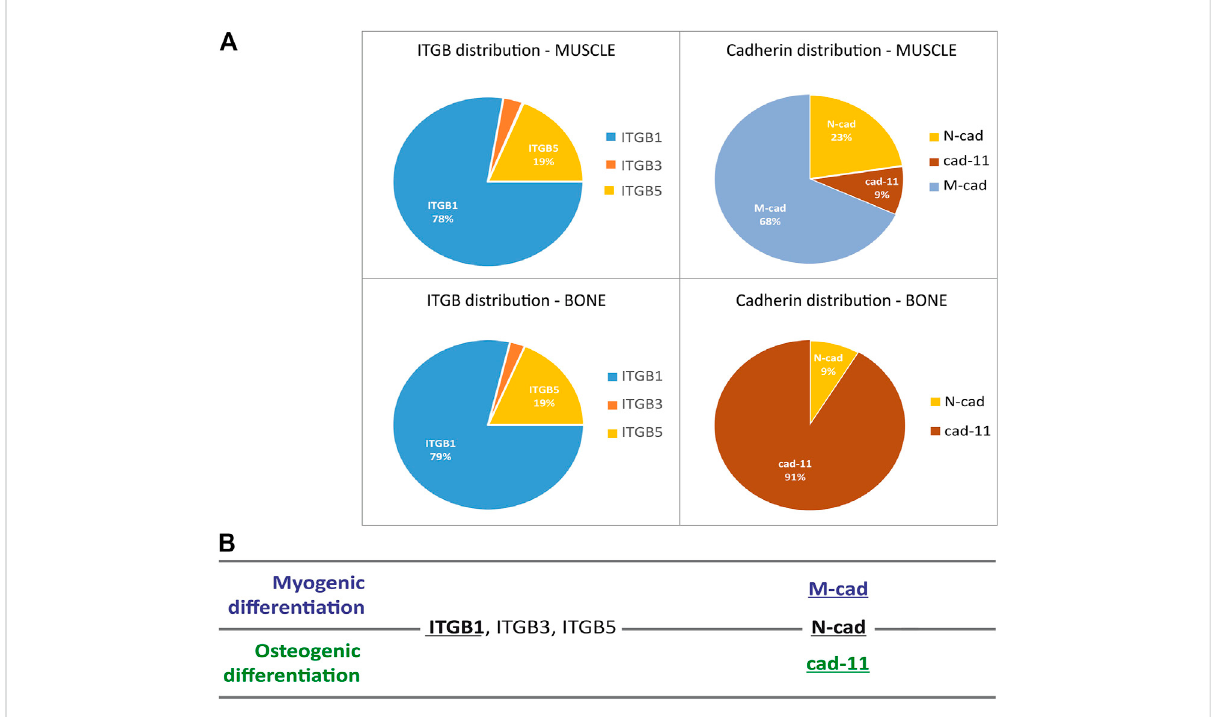
FIGURE 3 Identi fi cation using the ENCODE database of muscle and osteoblast-speci fi c integrins and cadherins. (A) Pie chart of the percentage of expression of ITGB1, three and fi ve chains (A) and M-, N- and cadherin and cadherin-11 in muscle and osteoblast cells. Data were obtained by analyzing RNA sequencing data made for the ENCODE public research project i.e., charts illustrate the predominance of certain adhesion receptors in each cell type. (B) Summary table highlighting the adhesion receptor repertoire for myogenic and osteogenic differentiation and